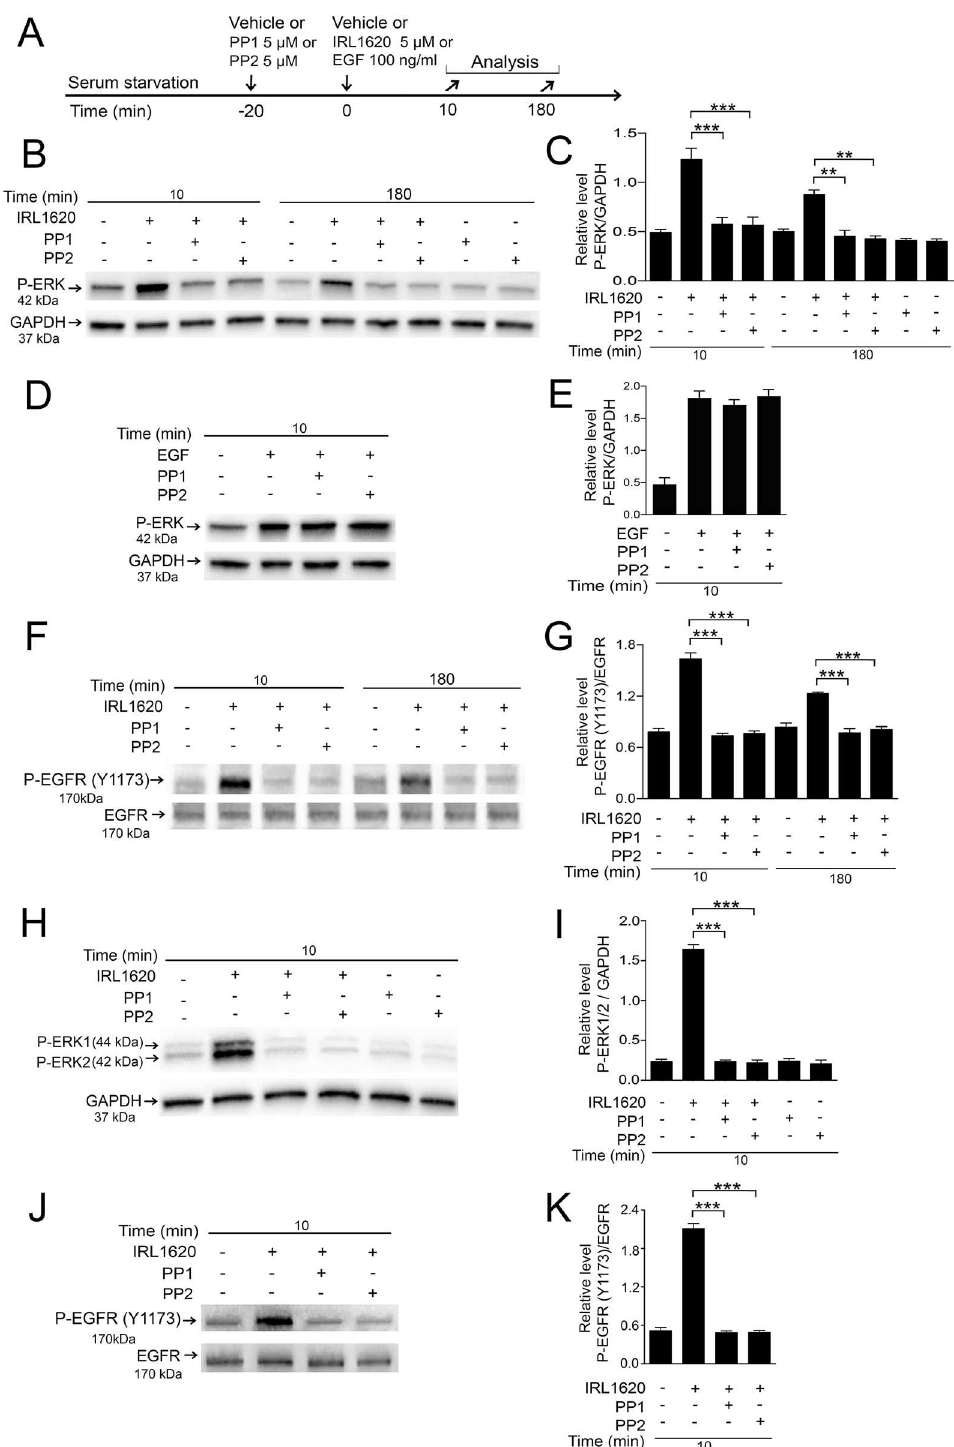
Fig 8. Effects of Src-kinase inhibitors PP1 and PP2 on IRL1620-induced P-ERK1/2 and P-EGFR (Y1173) in primary chicken Mu¨ller cells and the human MIO-M1 cell line. Serum-starved primary chicken Mu¨ller cells and humanMIO-M1 cells were pretreated with 5 μ M PP1 or 5 μ M PP2, or control (vehicle)for 20 min followedby treatment with 5 μ M IRL1620 or vehiclesand analyses. Western blot was used to analyzeERK- signaling with the different treatments. (A) Experimental outline. The MIO-M1 cells were only analyzedat